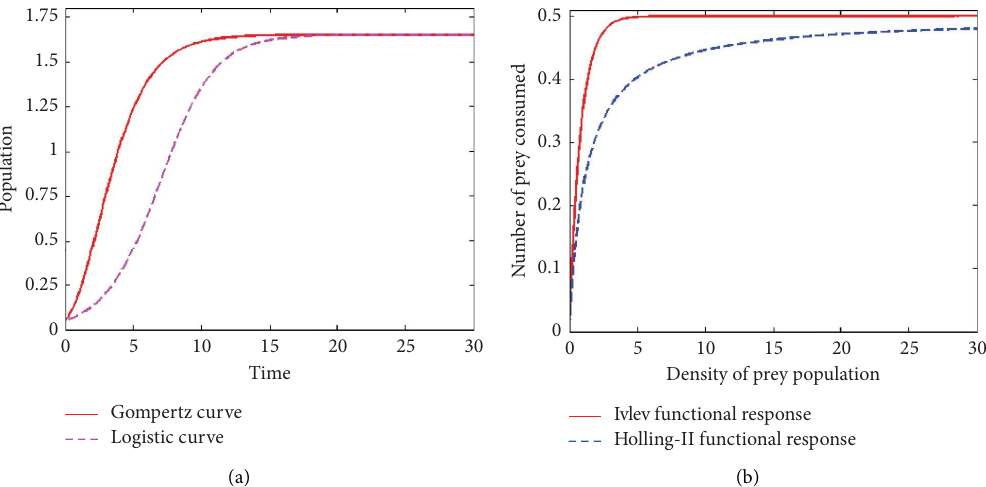
Figure 1: Comparison: growth curves and functional responses: (a) growth curves; (b) functional responses for r � 0 . 5 ,K � 1 . 65 , � 0 . a � 1 . 2 , α � 0 . 5 , β � 0 . 65 , d � 0 . 45 , P 0